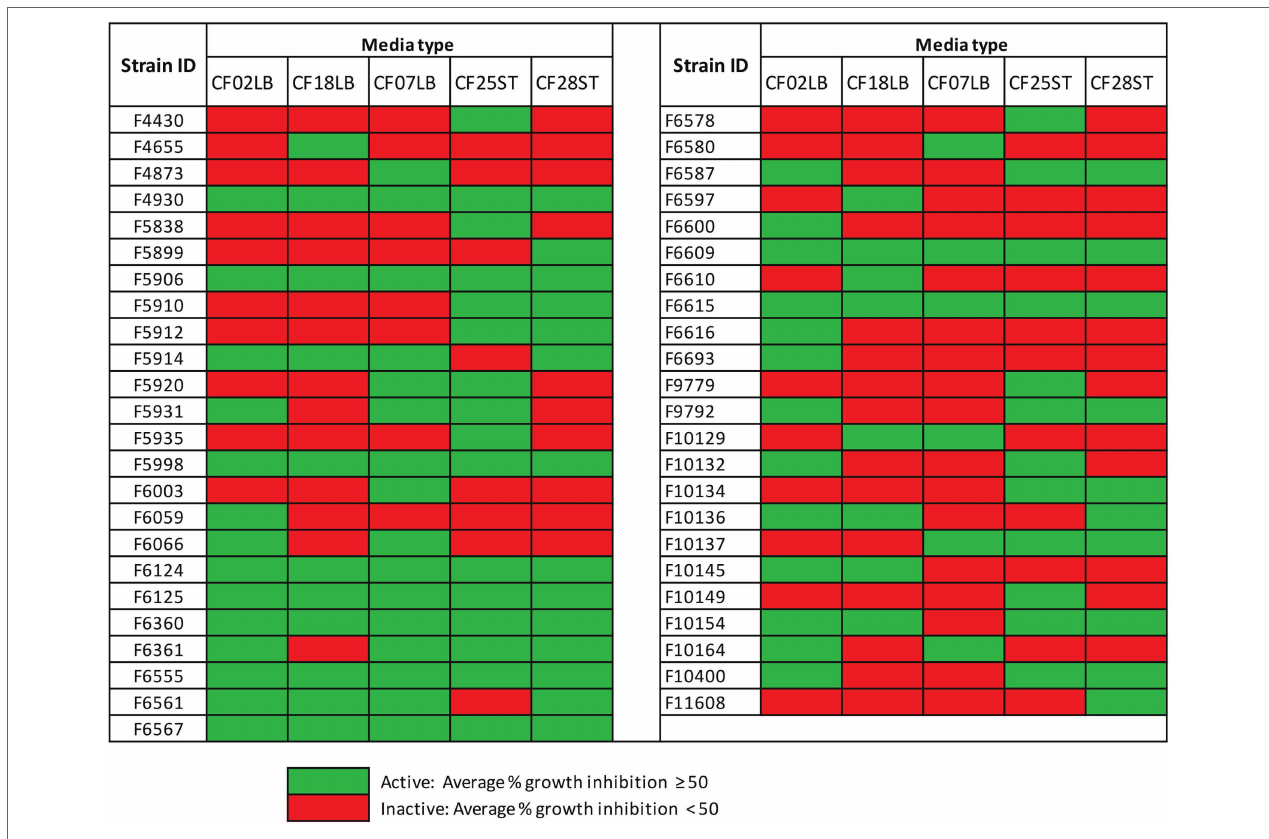
FIGURE 4 | Hits from 101 fungal strains grown two initial media (CF02LB, CF18LB) and three additional media (CF07LB, CF25ST, and